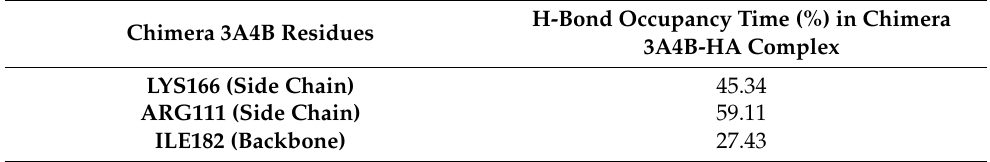
Table 4. Hydrogen bond (H-bond) occupancy of Chimera 3A4B–HA complex. Hydrogen bonds are measured with a cut-off distance of 3.5 Å and occupancy time > 5% are displayed in the